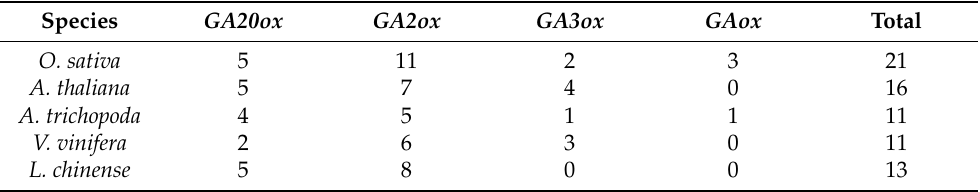
Table 1. Number of GAox genes in five species.